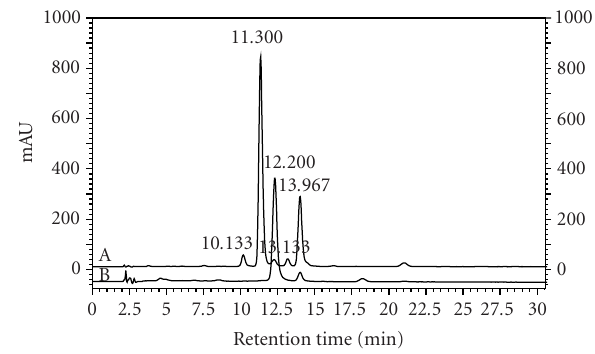
Figure 3. HPLC profile of sour cherry ( P cerasus L) cv Amarena Mattarello fruit extract (A) and callus extract (B). Chromatographic conditions as reported in the test. Identifi- cation peaks: cyanidin 3-sophoroside (t r 10 . 133); cyanidin 3- glucosylrutinoside (t r 11 . 300), cyanidin 3-glucoside (t r 12 . 200), cyanidin 3-rutinoside (t